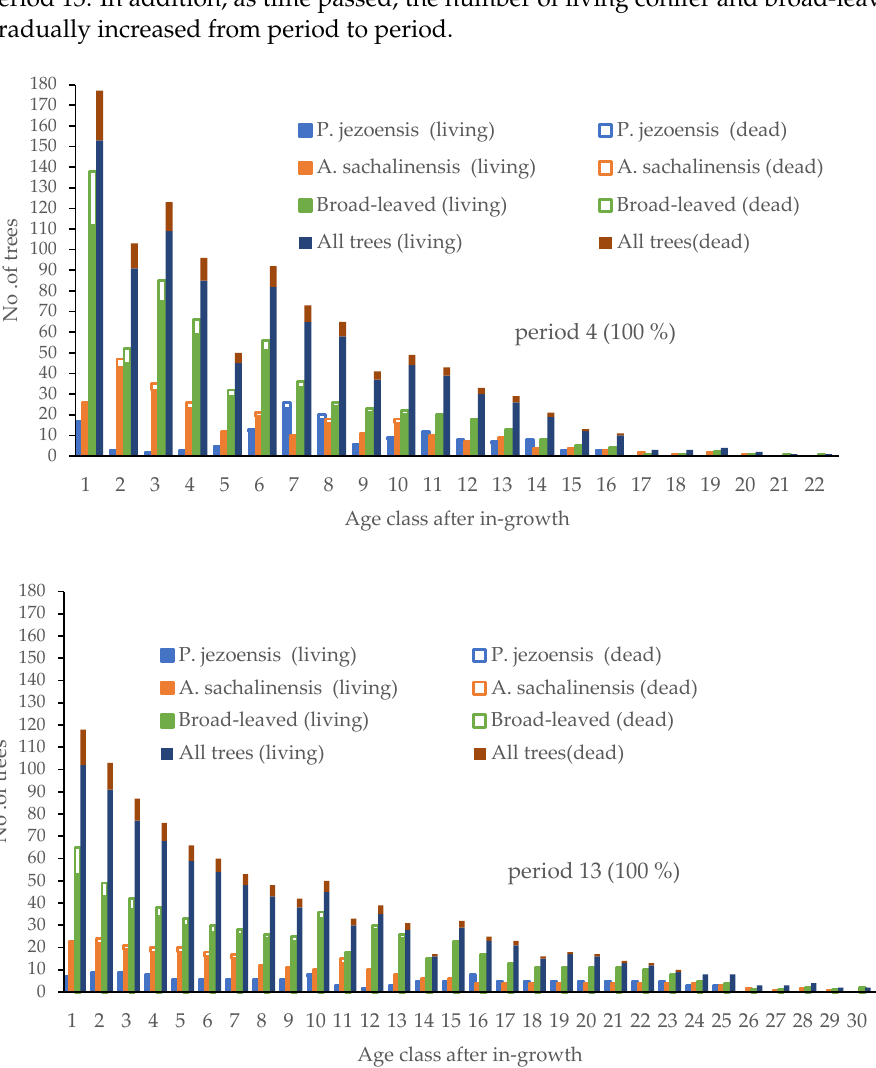
Figure 5. Future prediction results (100% scenario) of upcoming 100 years of conifer and broad-leaved trees; the rest of the periods are attached to the appendix section.